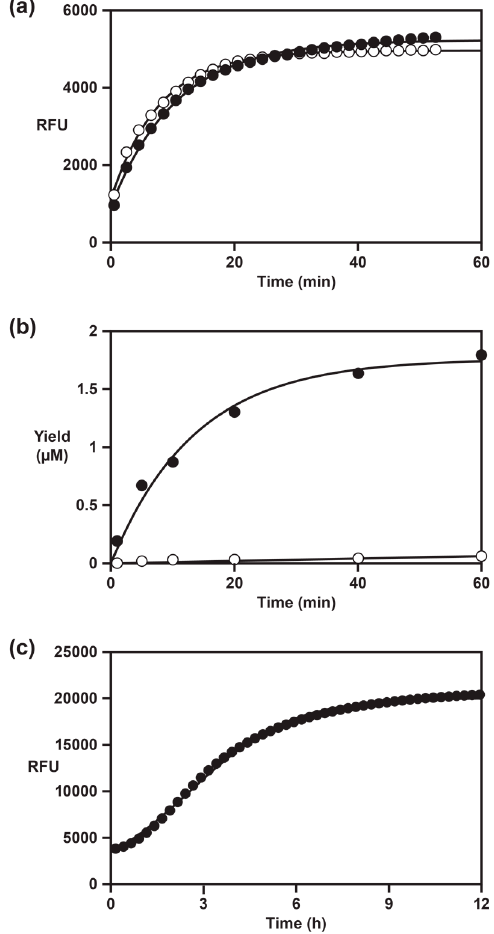
Figure 3. Functional properties of the selected RNA enzyme. ( a ) Real-time assay of RNA ligation, employing either D -RNA (black circles) or L -RNA (white circles). Values for k obs were obtained as in Figure 2b, with the yield based on relative fluorescent units (RFUs); ( b ) Ligand-dependent activity of an RNA enzyme that contains a theophylline-binding aptamer domain, measured in either the presence (black circles) or absence (white circles) of theophylline; ( c ) Real-time monitoring of exponential amplification. The data were fit to the logistic growth equation: RFU = a /(1 + b e –c t ), where a is the maximum extent, b is the degree of sigmoidicity, and c is the exponential growth rate.